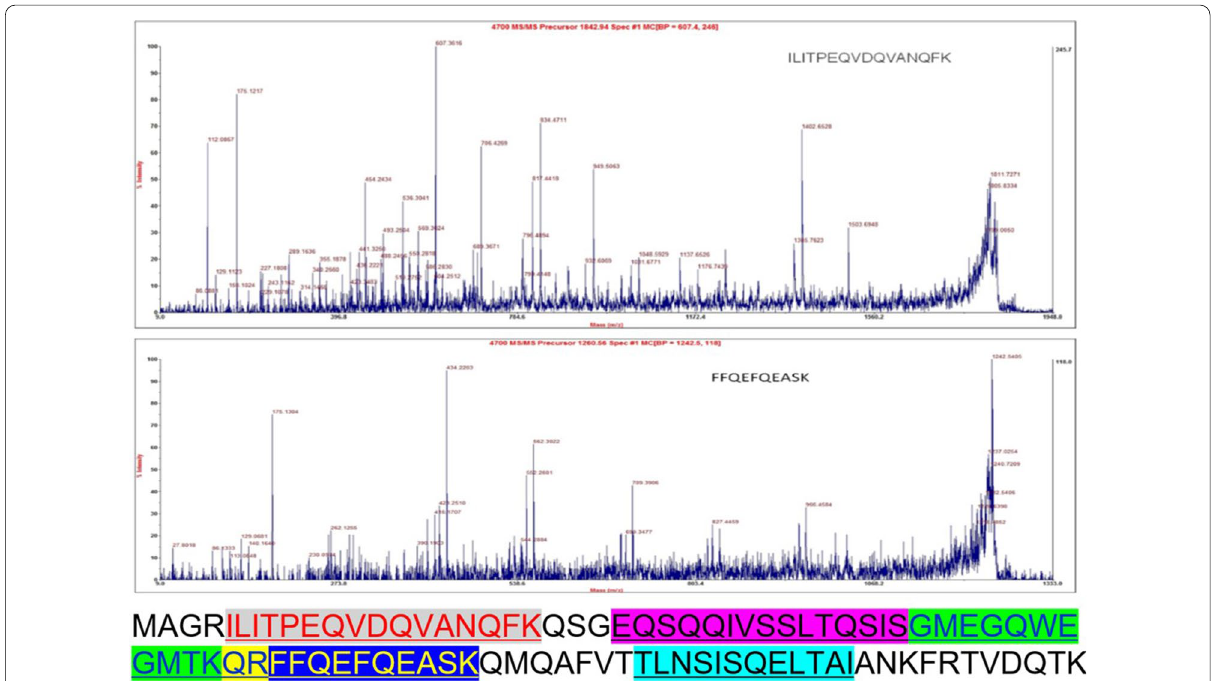
Fig. 4 Secondary mass spectra of EsxA peptides as well as the identified peptide fragments and their positions. The underlined amino acids indicate the identified sequences. The different font colors and different backgrounds represent the identified peptide